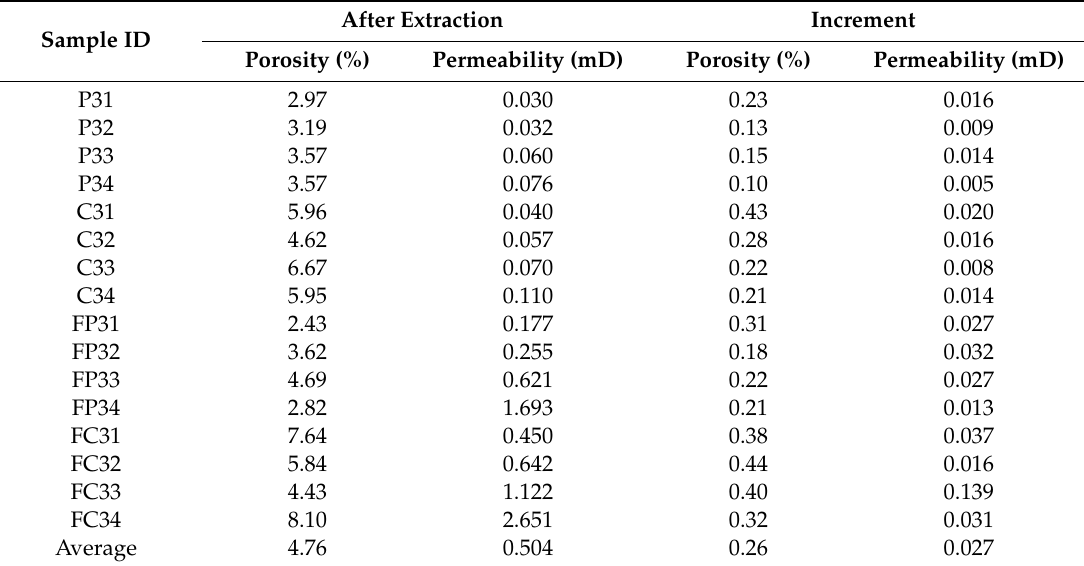
Table 2. Influence of SB on porosity and